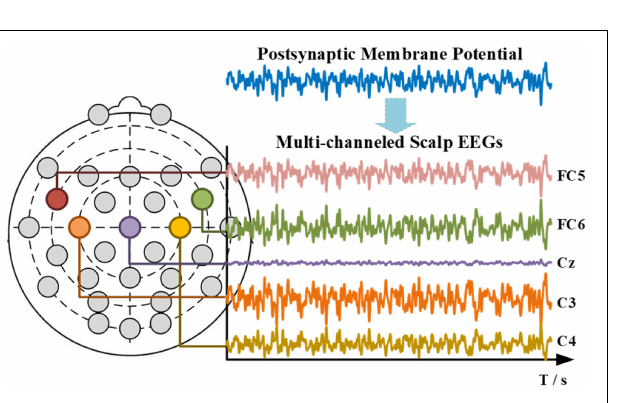
FIGURE 16 | Simulated micro right-smirk multi-channeled scalp EEGs (in aesthetics consideration, only parts of channels are shown).